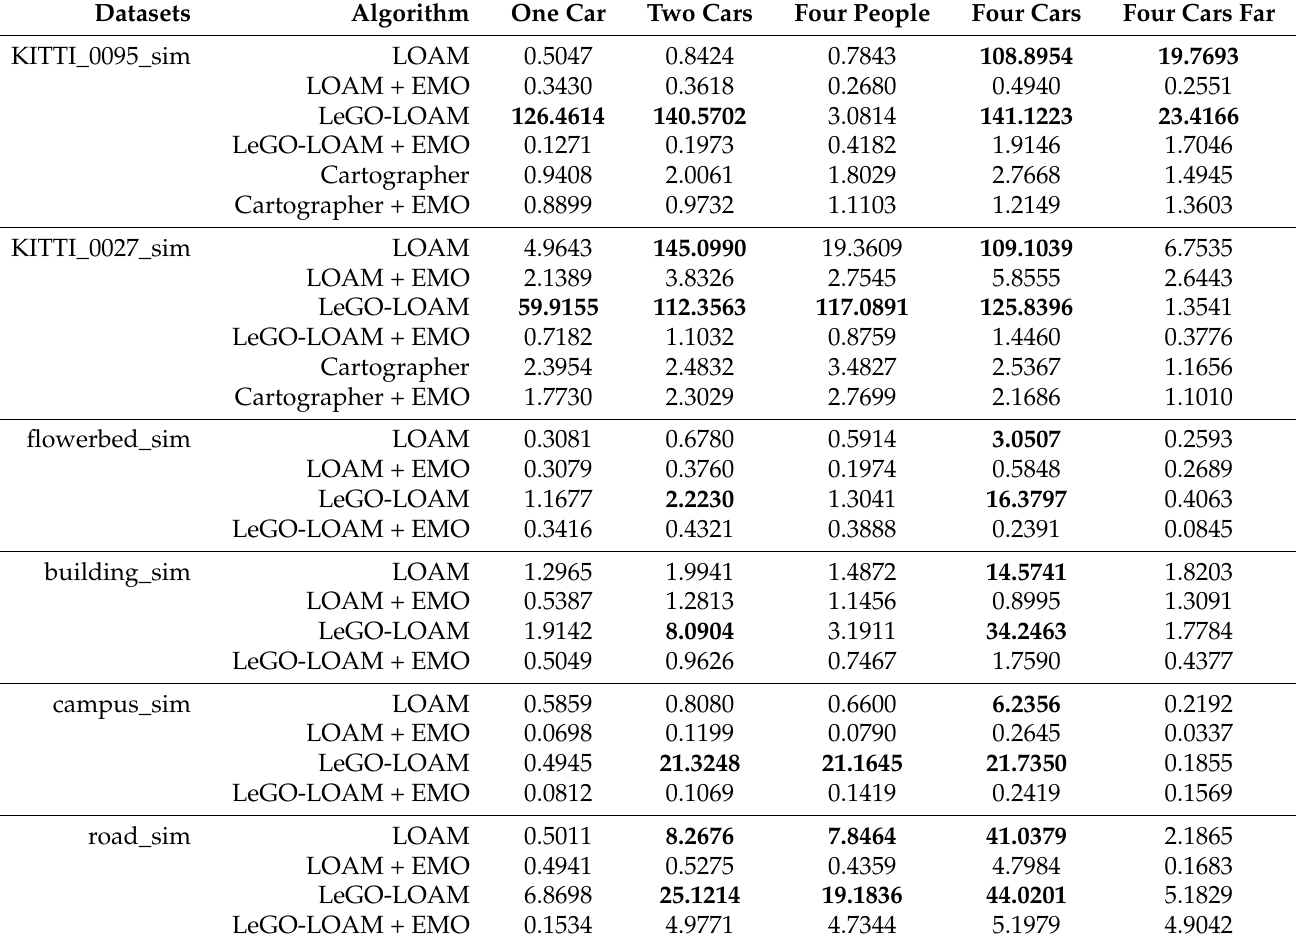
Table 1. The absolute position RMSE (unit: m) of odometry results from Cartographer, LOAM and LeGO-LOAM in six semi-physically simulated datasets with and without our proposed method (EMO). The bold number indicate obvious odometry drift or